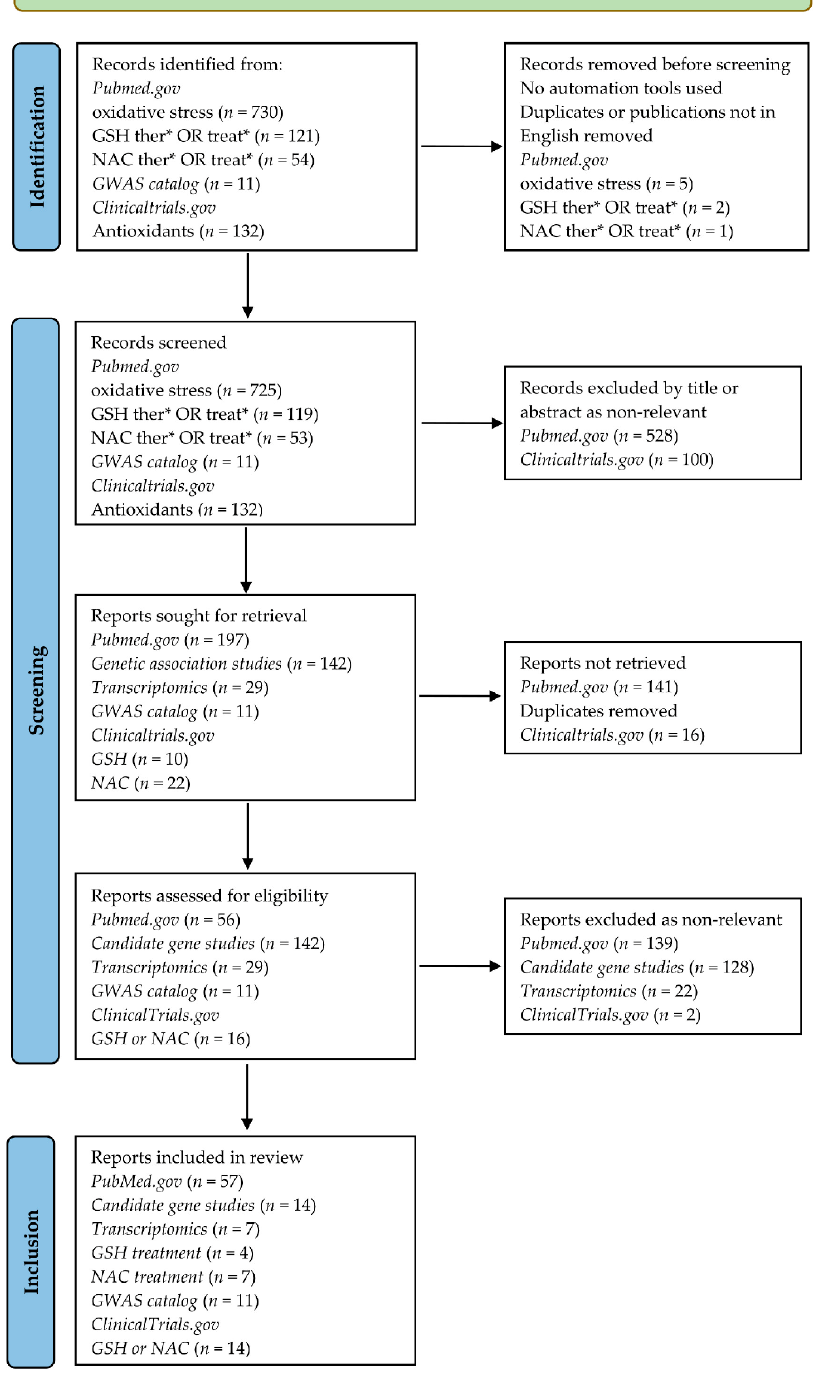
Figure 3. PRISMA diagram. *- asterisk at the root of the PubMed search terms represents any group of characters, including no character.